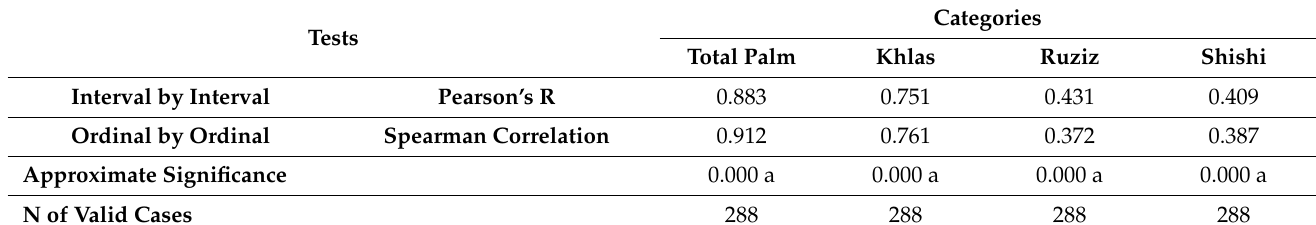
Table 2. Pearson’s R (interval by interval) and Spearman correlation (ordinal by ordinal) tests.